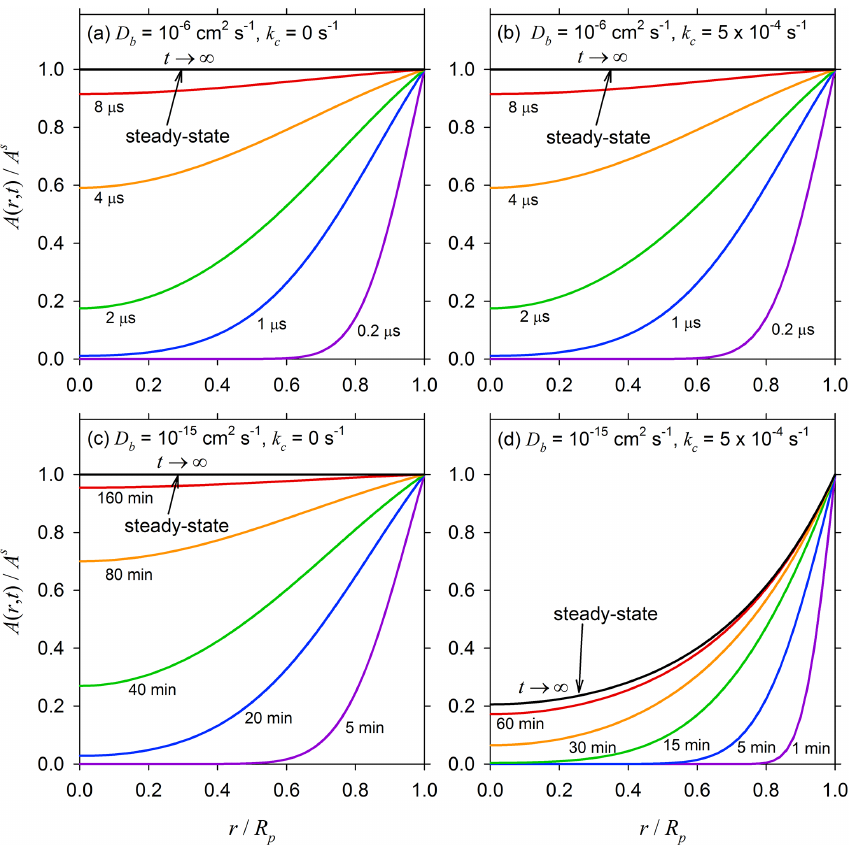
Figure 2. Normalized transient concentration (A(r,t)/A s ) profiles as a function of normalized radius ( r/R p ) for a particle of diameter R p = 0.05µm for different values of bulk-phase diffusivity and first-order reaction rate constants: (a) D b = 10 − 6 cm 2 s − 1 , k c = 0s − 1 ;